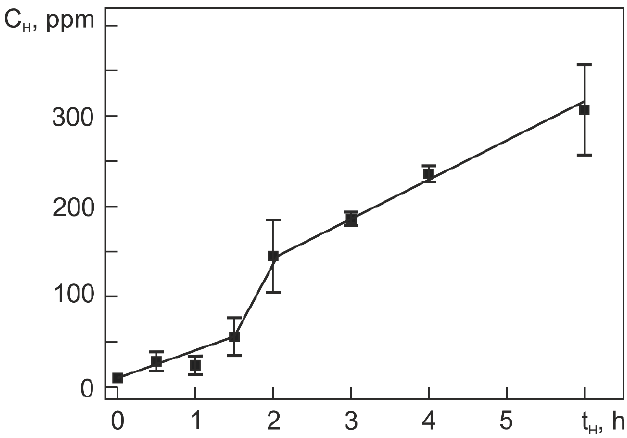
Figure 3. Hydrogen concentration vs. hydrogenation time in Ti 49.4 Ni 50.6 (at%).